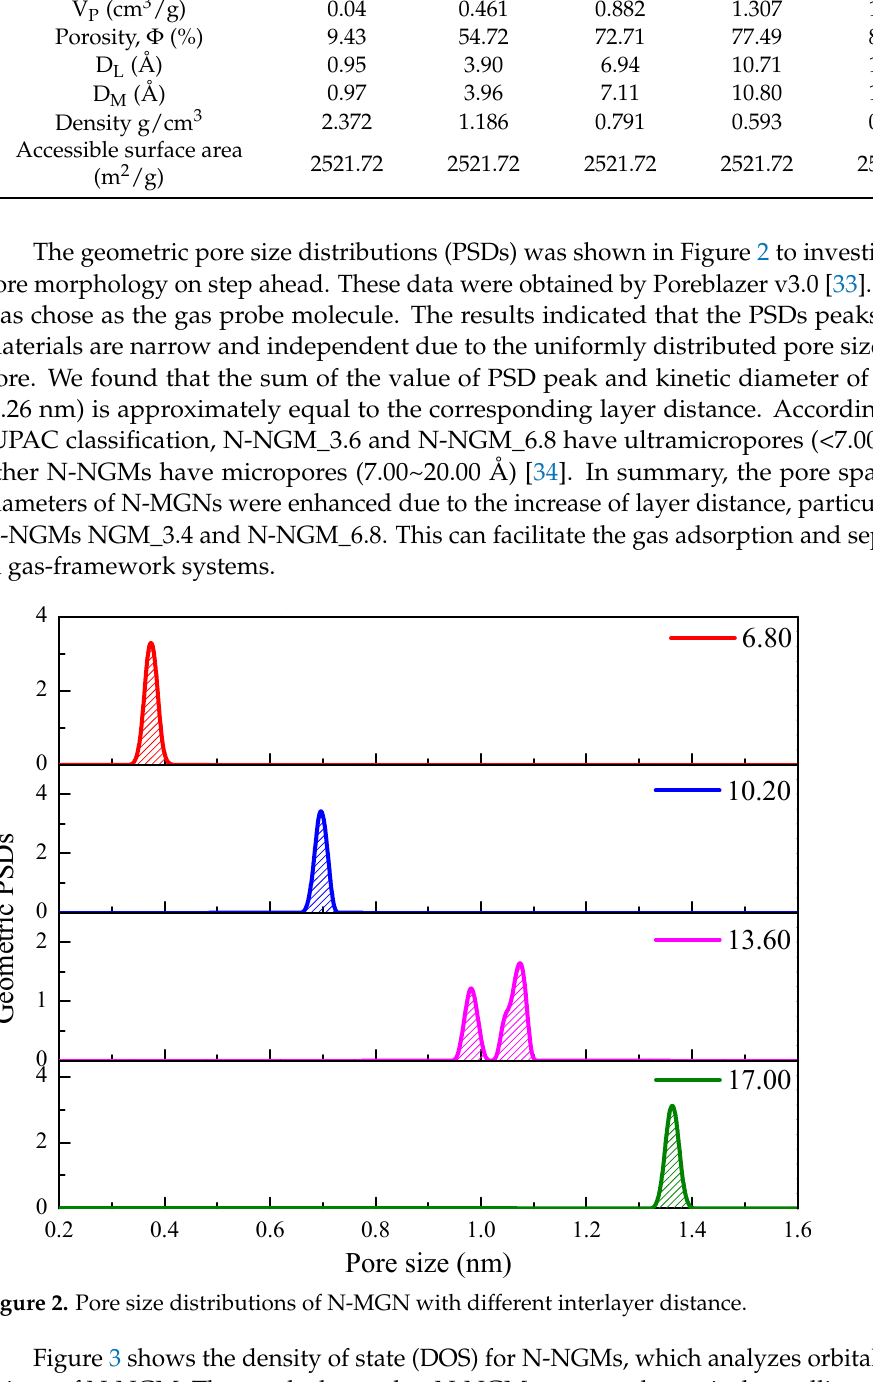
Table 2. Pore physical characteristics of N-MGNs, gas probe molecule = He.